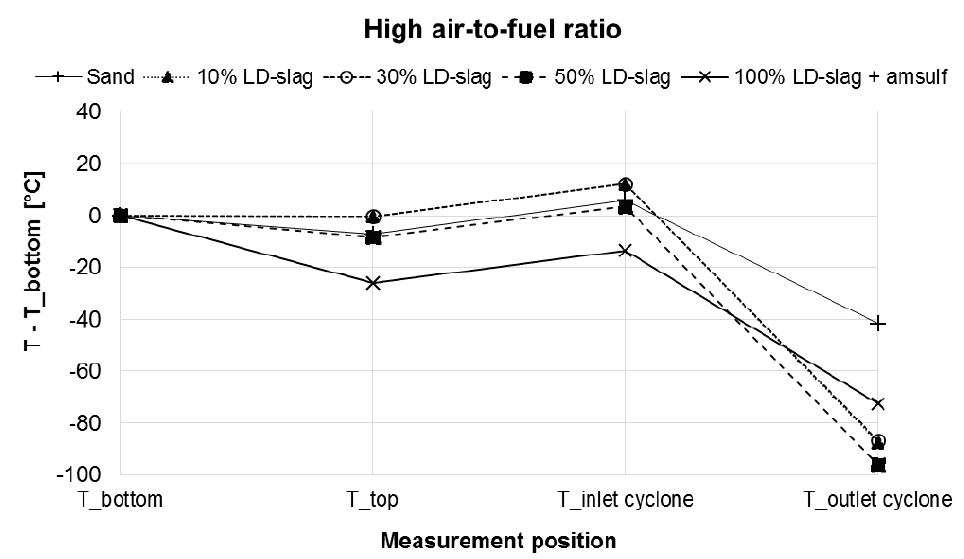
Figure 5. Temperature profile over the boiler when operated with high air-to-fuel-ratio. Note that the cases with 10% and 30% LD-slag overlaps so well that they are difficult to distinguish.